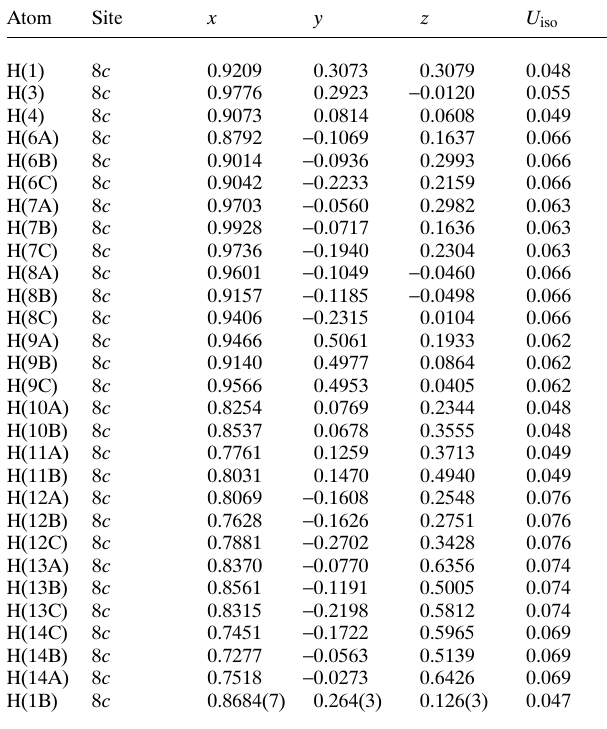
Table 2. Atomic coordinates and displacement parameters (in Å 2 )